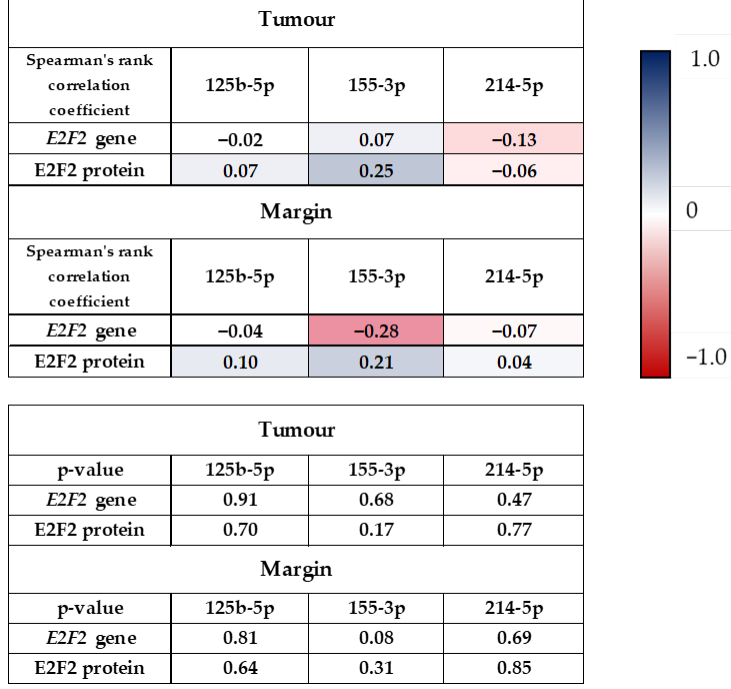
Figure 3 . Correlation between the expressions of E2F2 gene, E2F2 protein, and the tested miRNAs in tumour and margin samples. tumour and margin